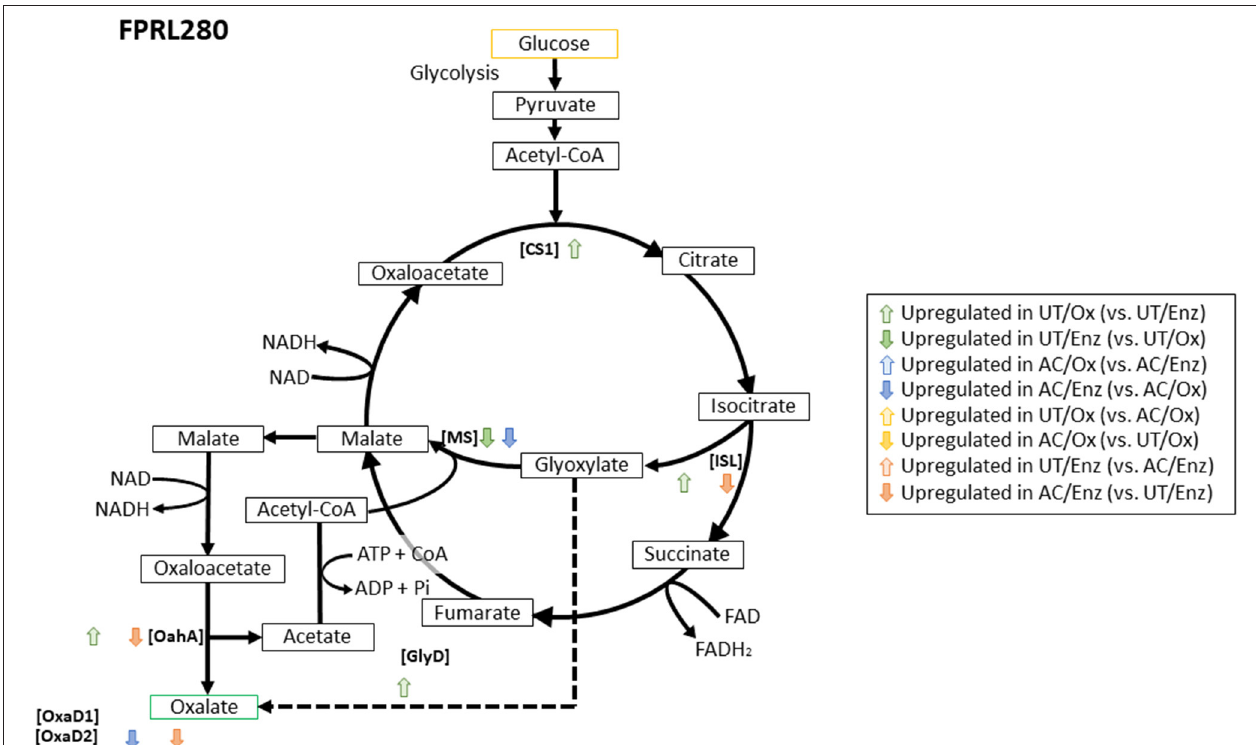
FIGURE 8 | Metabolic mechanisms for the oxalate biosynthesis in the TCA cycle and the GLOX cycle in R. placenta (FPRL280). Activities of the involved enzymes: [ISL] Isocitrate lyase; [CS] Citrate synthase; [MS] Malate synthase; [GlyD] Glyoxylate dehydrogenase; [OahA] Oxaloacetase; [OxaD] Oxalate decarboxylase. Modified graphic, based on Munir et al.